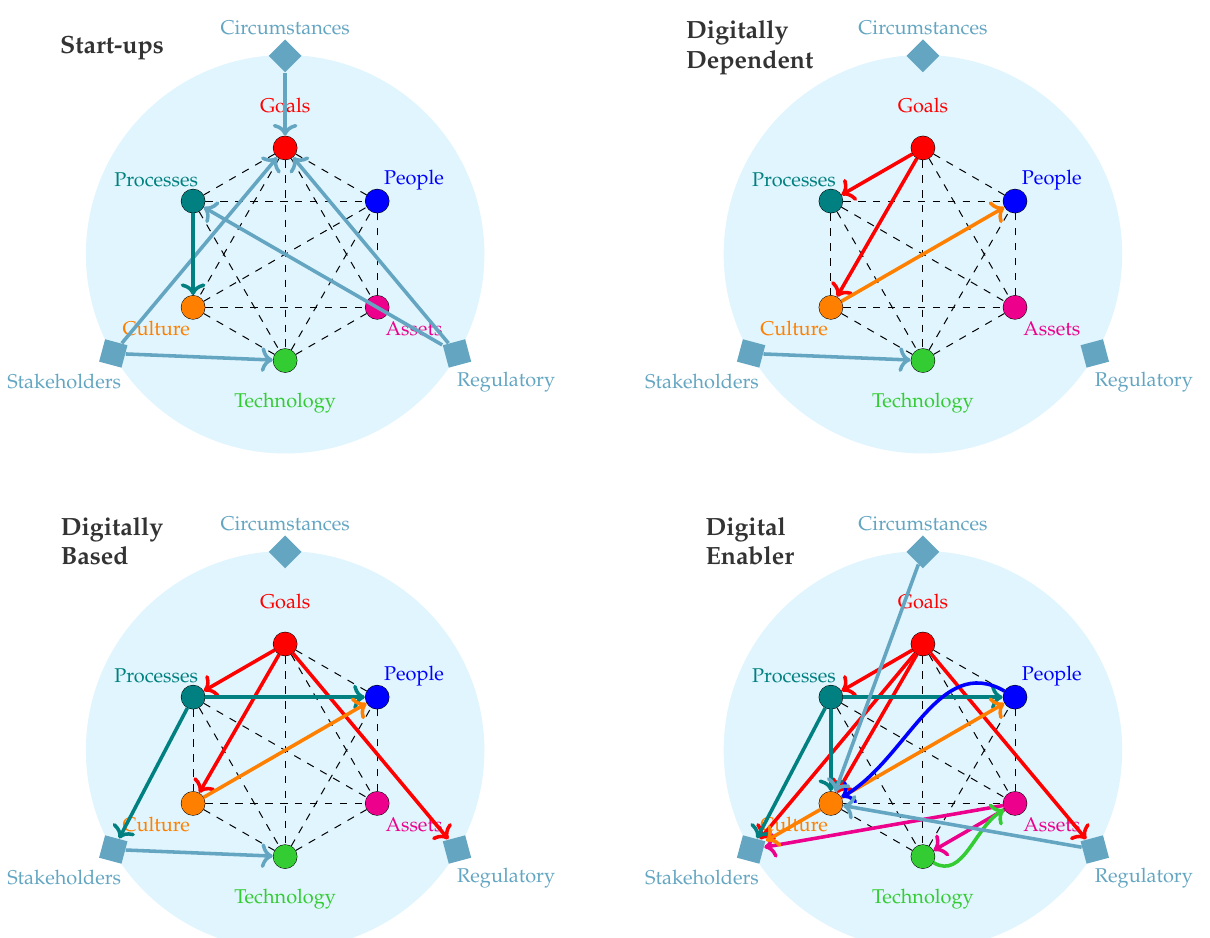
Figure 4. A visualisation of the framework presented in Table 10 using the representation of Figure